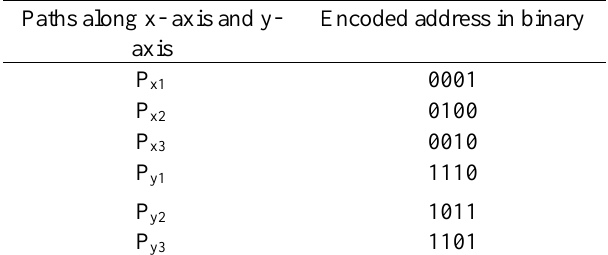
Addresses of paths encoded along the x-direction and y- direction: Paths along x- axis and